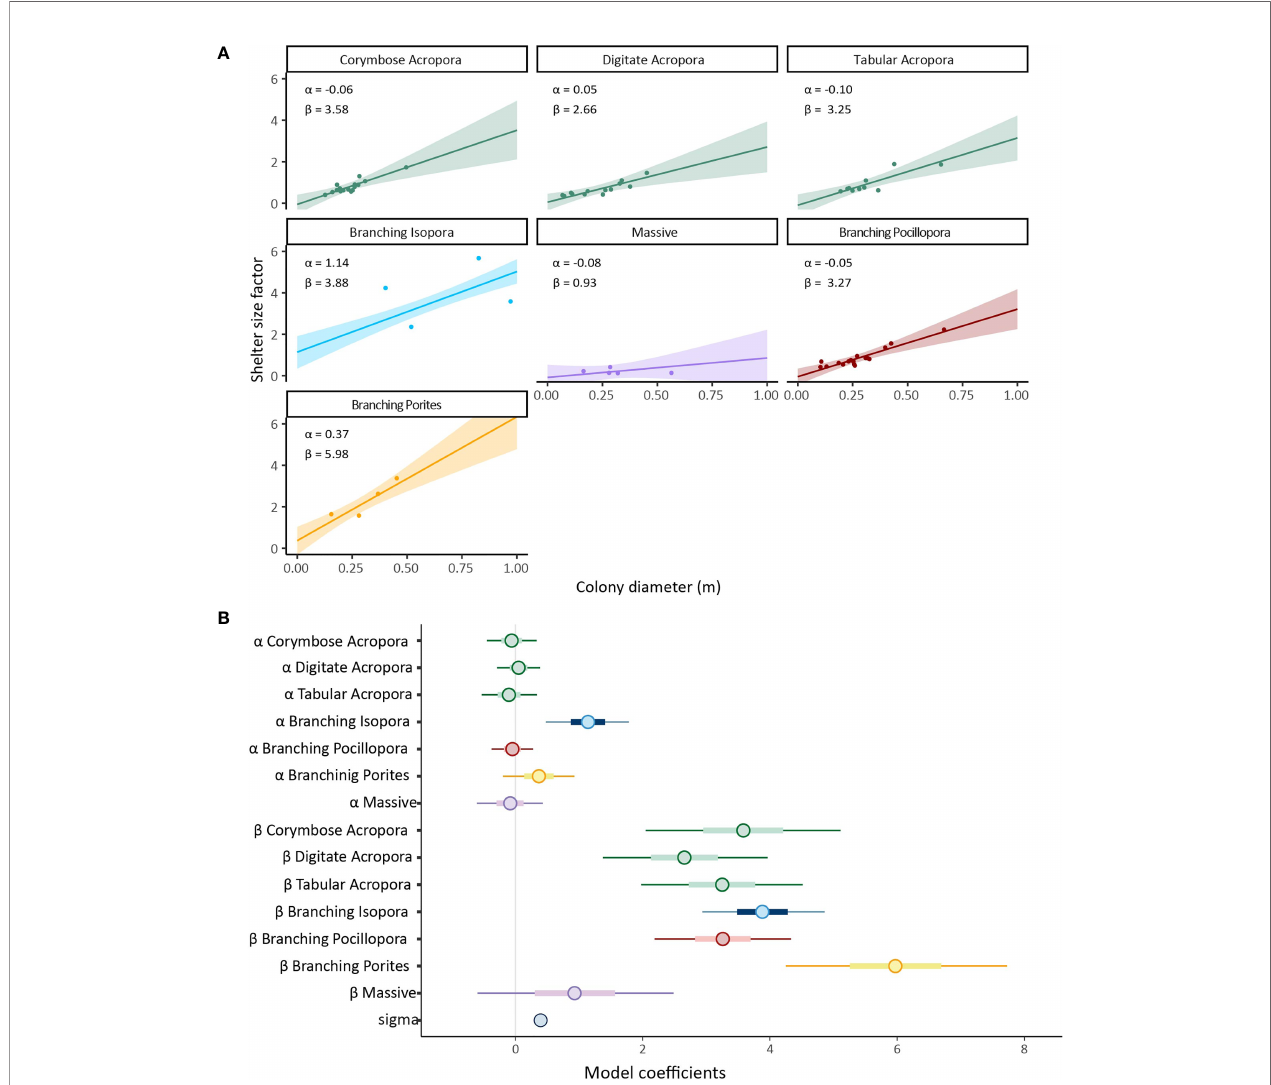
FIGURE 3 | (A) Plotted posteriors from linear model of shelter size factor from the interaction model containing colony diameter as a predictor for each of the seven mophotaxa. Shaded regions are 95% highest density probability intervals and solid lines are mean slopes of the mean from the posterior probability distribution. (B) Posterior predictions for intercept ( a ) and slope ( b ) parameters in the same model. Circles indicate means, thick blue bars are 50% credible intervals, thin blue line are 95% credible intervals. All model coe fi cients including posterior uncertainty are avilable numerically in Table S3